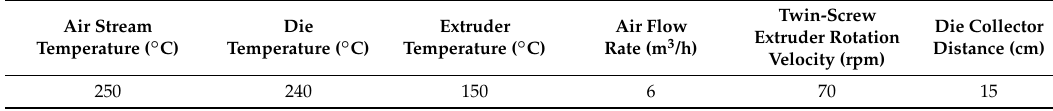
Table 4. Melt blowing processing parameters used for PLLAGLTMC nonwoven fabric formation.